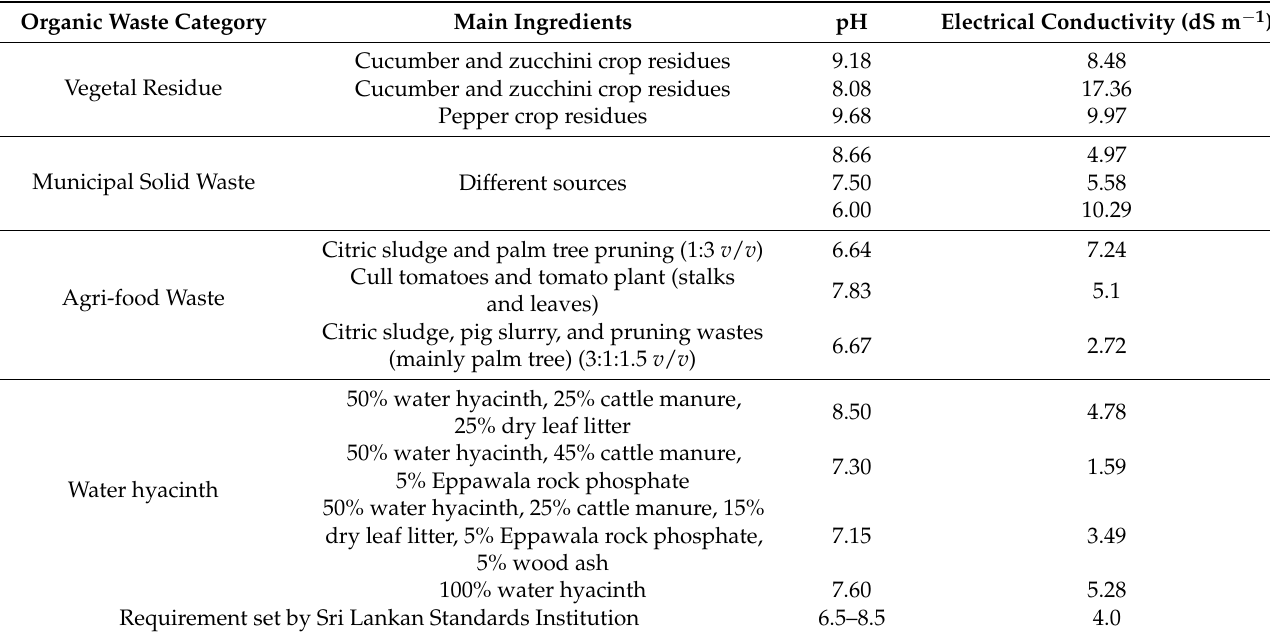
Table 4. Comparison of different chemical properties in different compost materials from various raw materials [65,66,69].